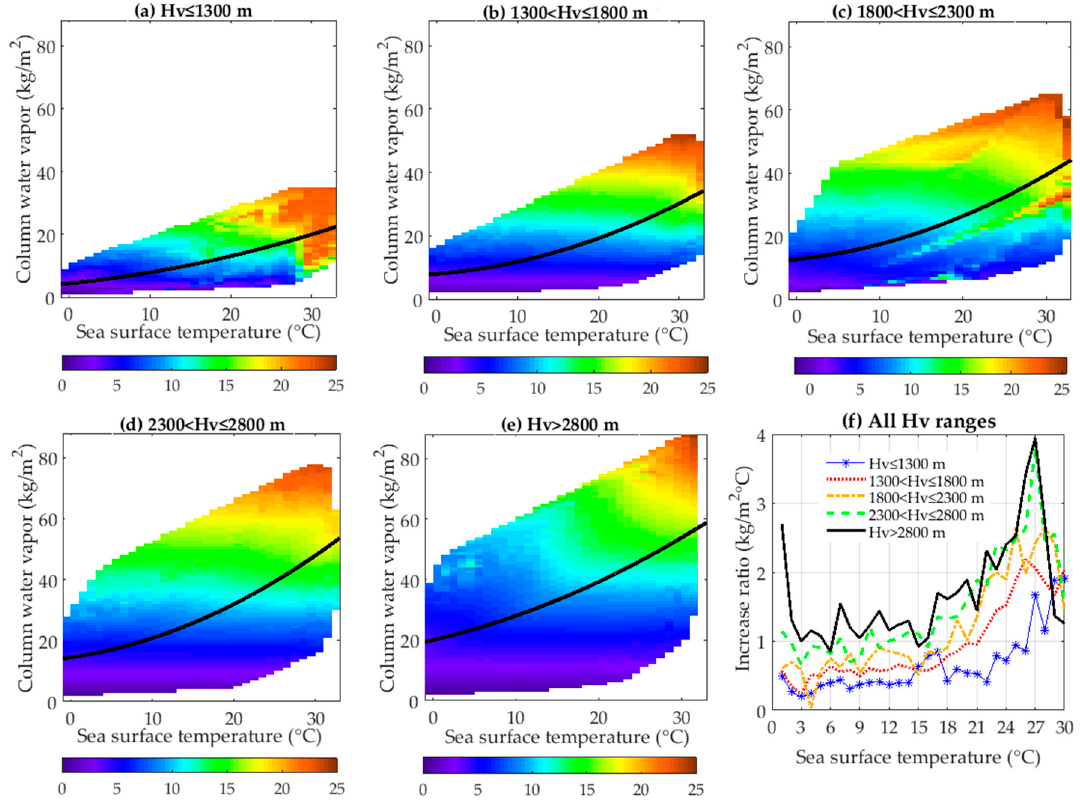
Figure 2. ( a – e ) The relationship between sea surface temperature (SST), column water vapor (W), and surface water vapor mixing ratio q v (g/kg, color) on different ranges of water vapor scale height H v (m). Each figure shows a cubic regression curve calculated from SST and W. ( f ) SST compared to increase ratio (W/SST, kg/m 2 · ◦ C) over five H v ranges, calculated from daily data and averaged from the range of 60 ◦ S to 60 ◦ N.